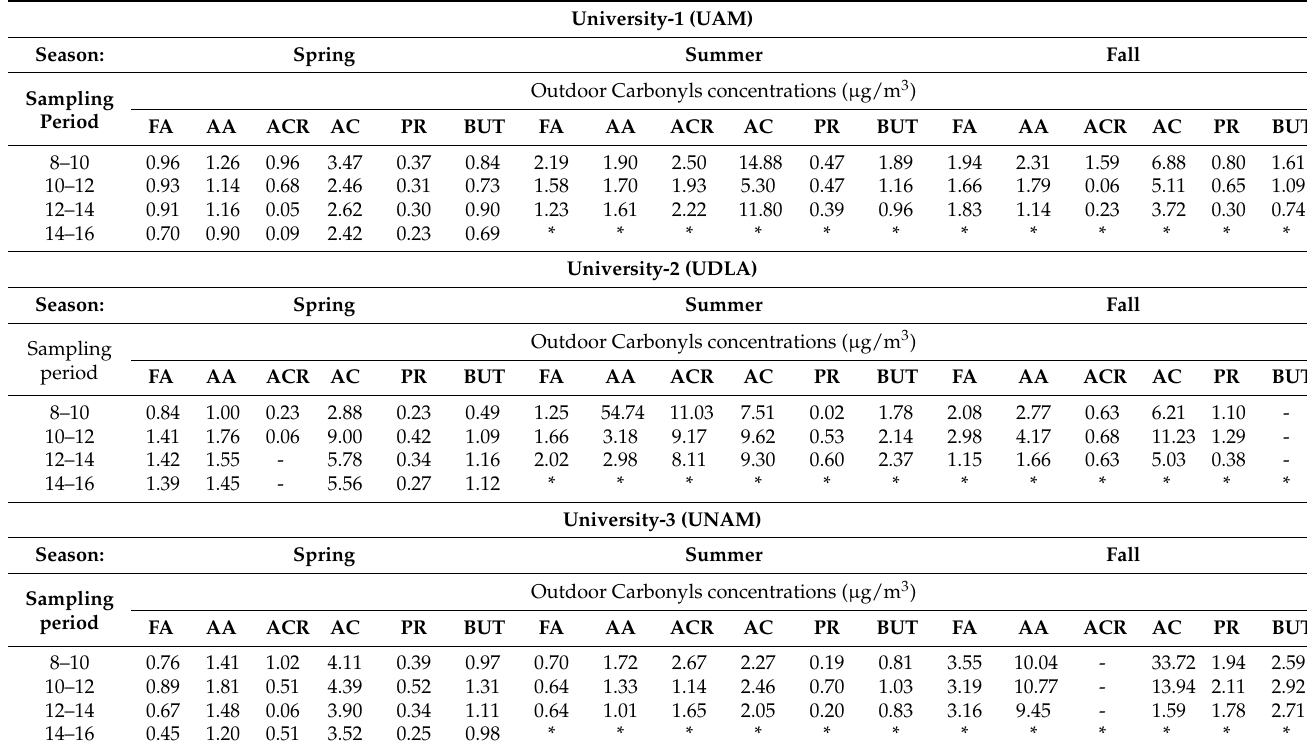
Table 6. Diurnal variation of carbonyl outdoor concentrations at the three sampling sites (University-1 UAM, University-2 UDLA and University-3 UNAM) during the three sampling campaigns. University-1